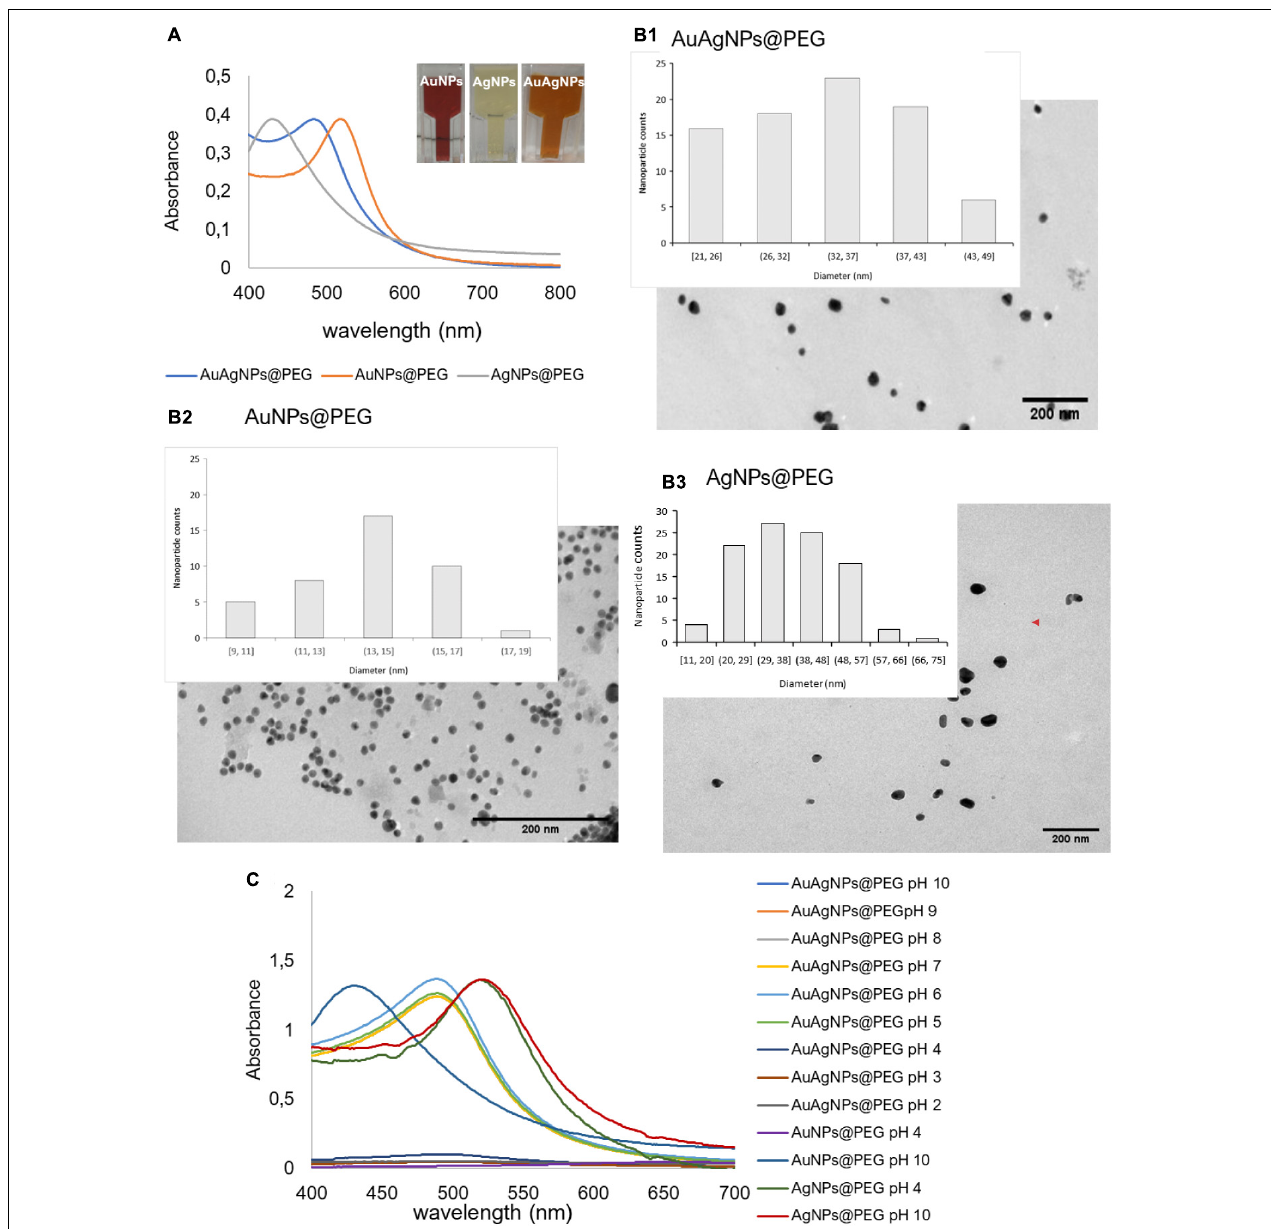
FIGURE 2 | (A) Ultraviolet-spectrum of produced nanoparticles. AuNPs solution show an intense red color corresponding to a LSPR peak at 520 nm; AgNPs solution showed the typical faint yellow color corresponding to the LSPR peak at 430 nm; the alloy AuAgNPs resulted orange with an LSPR peak at 484 nm. (B1–3) Respective TEM images NPs with indication of the size distribution. (C) Ultraviolet spectra of NPs in different pH solutions correlating to the colloid stability of the different